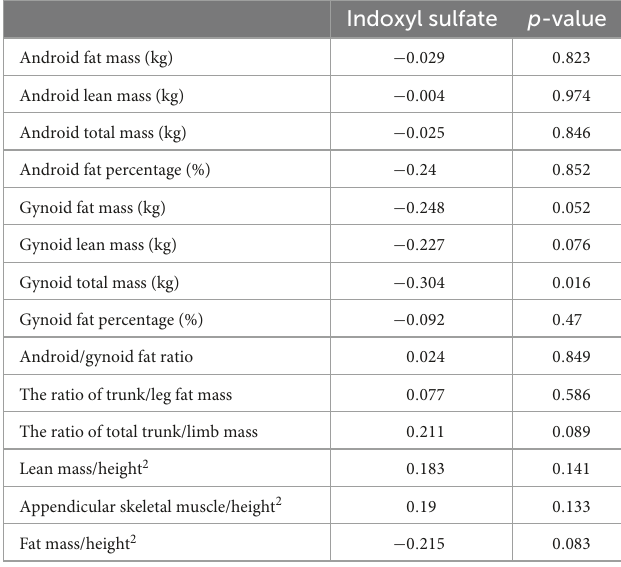
TABLE 8 Correlations between indoxyl sulfate and body composition in total population.